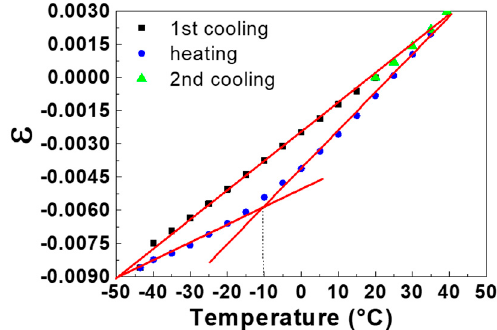
Figure 7. Linear strain, ε , vs. temperature of a LDPE sample subjected to a cooling-heating-cooling cycle. The solid straight lines are linear fit lines, and the vertical dot line allows to determine the β second-order transition temperature.